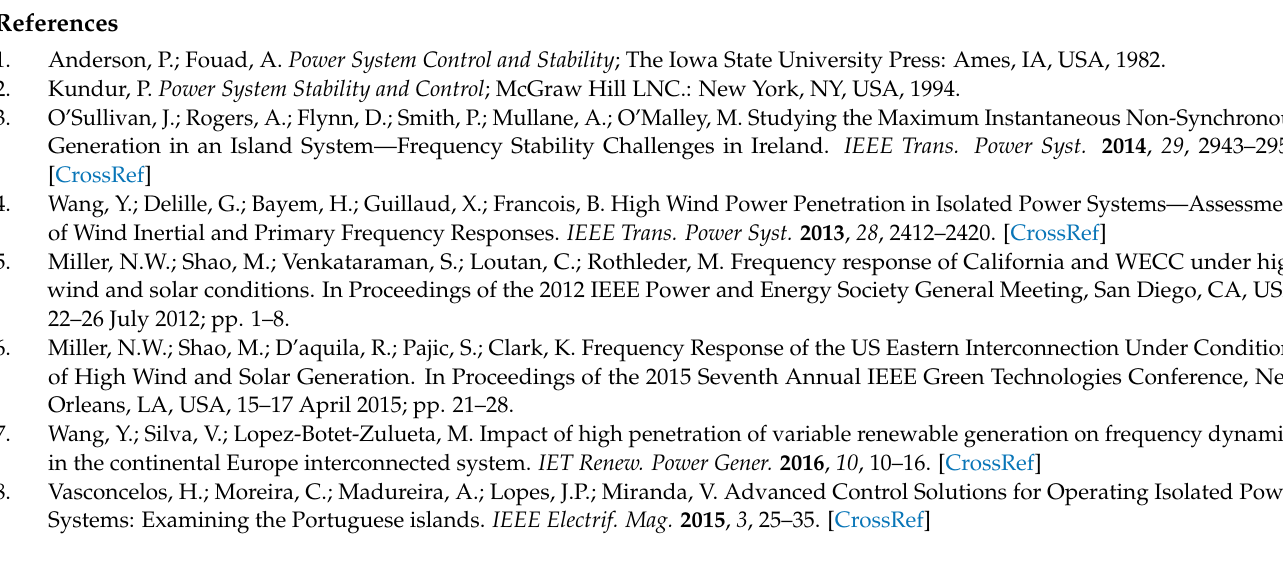
Figure A1. A principal scheme of Israel Power System.